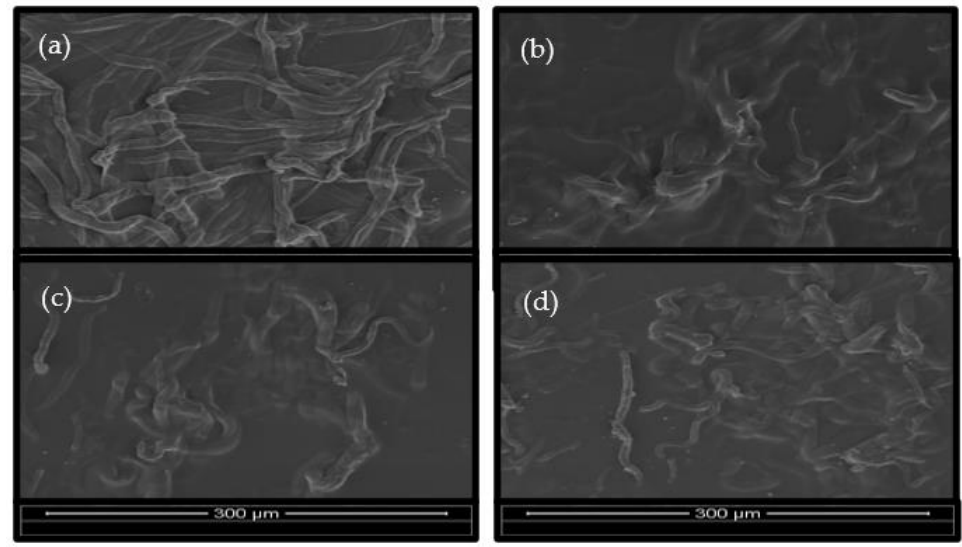
Figure 7. SEM micrographs of the surface morphology of the all-cellulose composites at different dissolution times: ( a ) ACC5, ( b ) ACC15, ( c ) ACC30, and ( d ) ACC45. (magnification ×500).